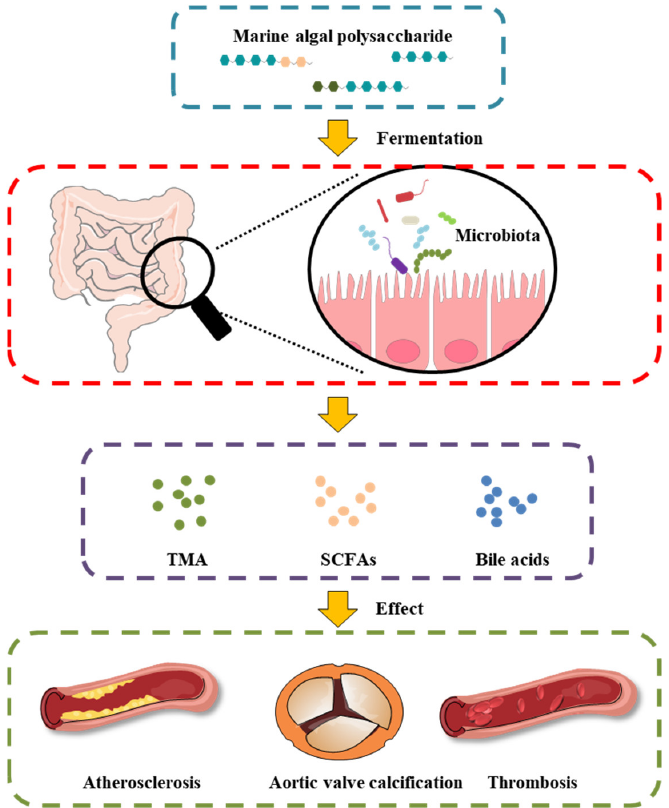
Figure 2. Effect of MAP on the intestinal microbiota and gut-derived metabolites in CVD. Table 2. Marine algal polysaccharides and their effect on CVD prevention through gut microbiota.